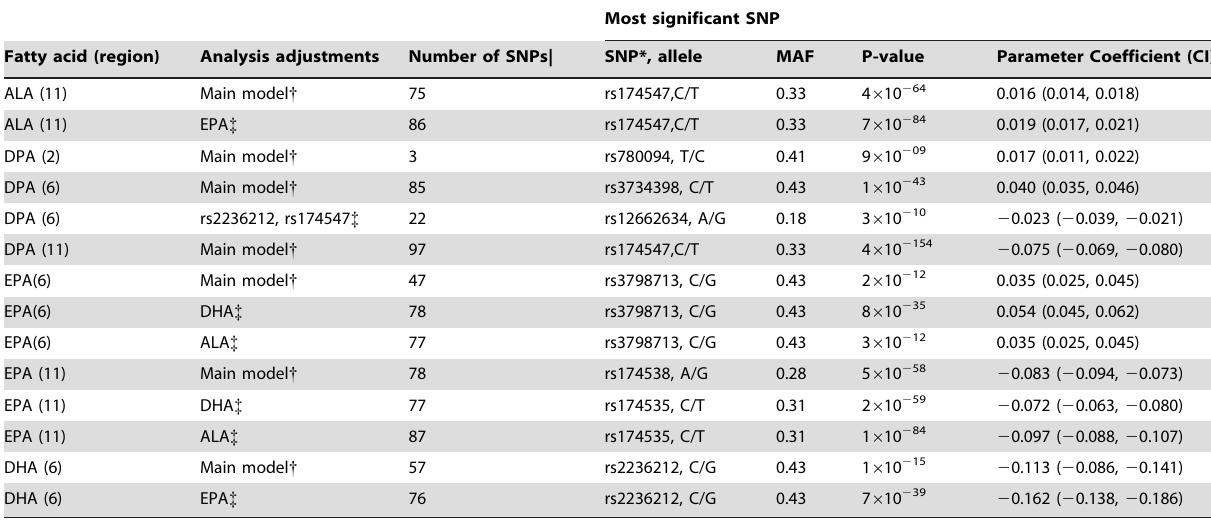
Table 2. Loci associated with SNP markers with P-values , 5.0 6 10 2 8 .